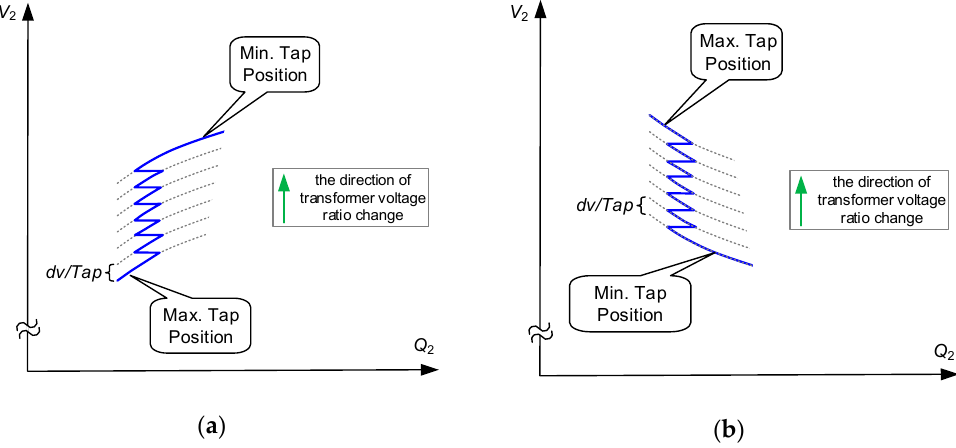
Figure 6. Influence of transformer tap position changes on the V - Q characteristics: ( a ) the situation corresponds to work in point “b” shown in Figure 3a; ( b ) the situation corresponds to work in point “a” shown in Figure 3a.